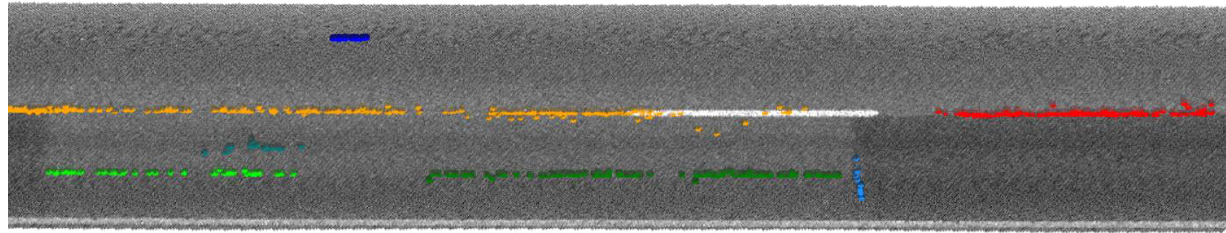
Figure 8. Connected clusters.